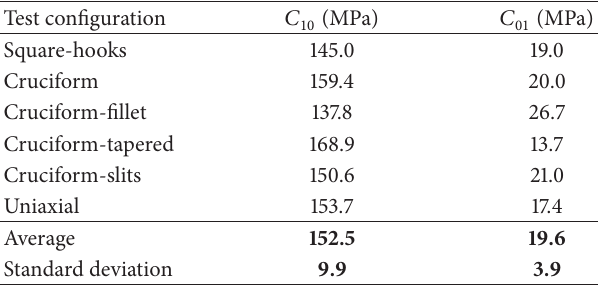
Table 1: Values of 𝐶 10 and 𝐶 01 parameters identified for different specimen